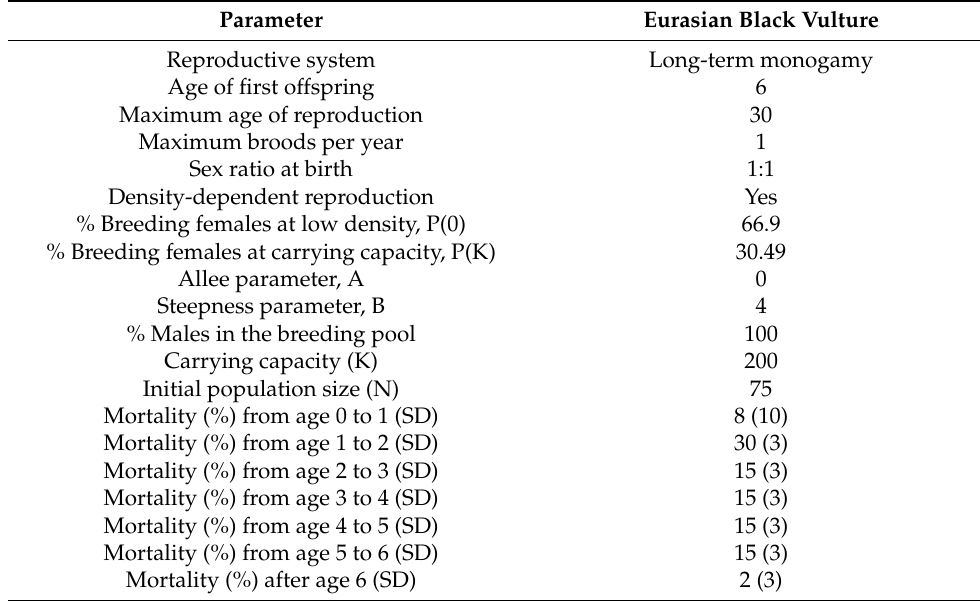
Table 1. Input parameters used in the basic scenario for the Population Viability Analysis of the Eurasian Black Vulture ( Aegypiusmonachus ) in Southeast